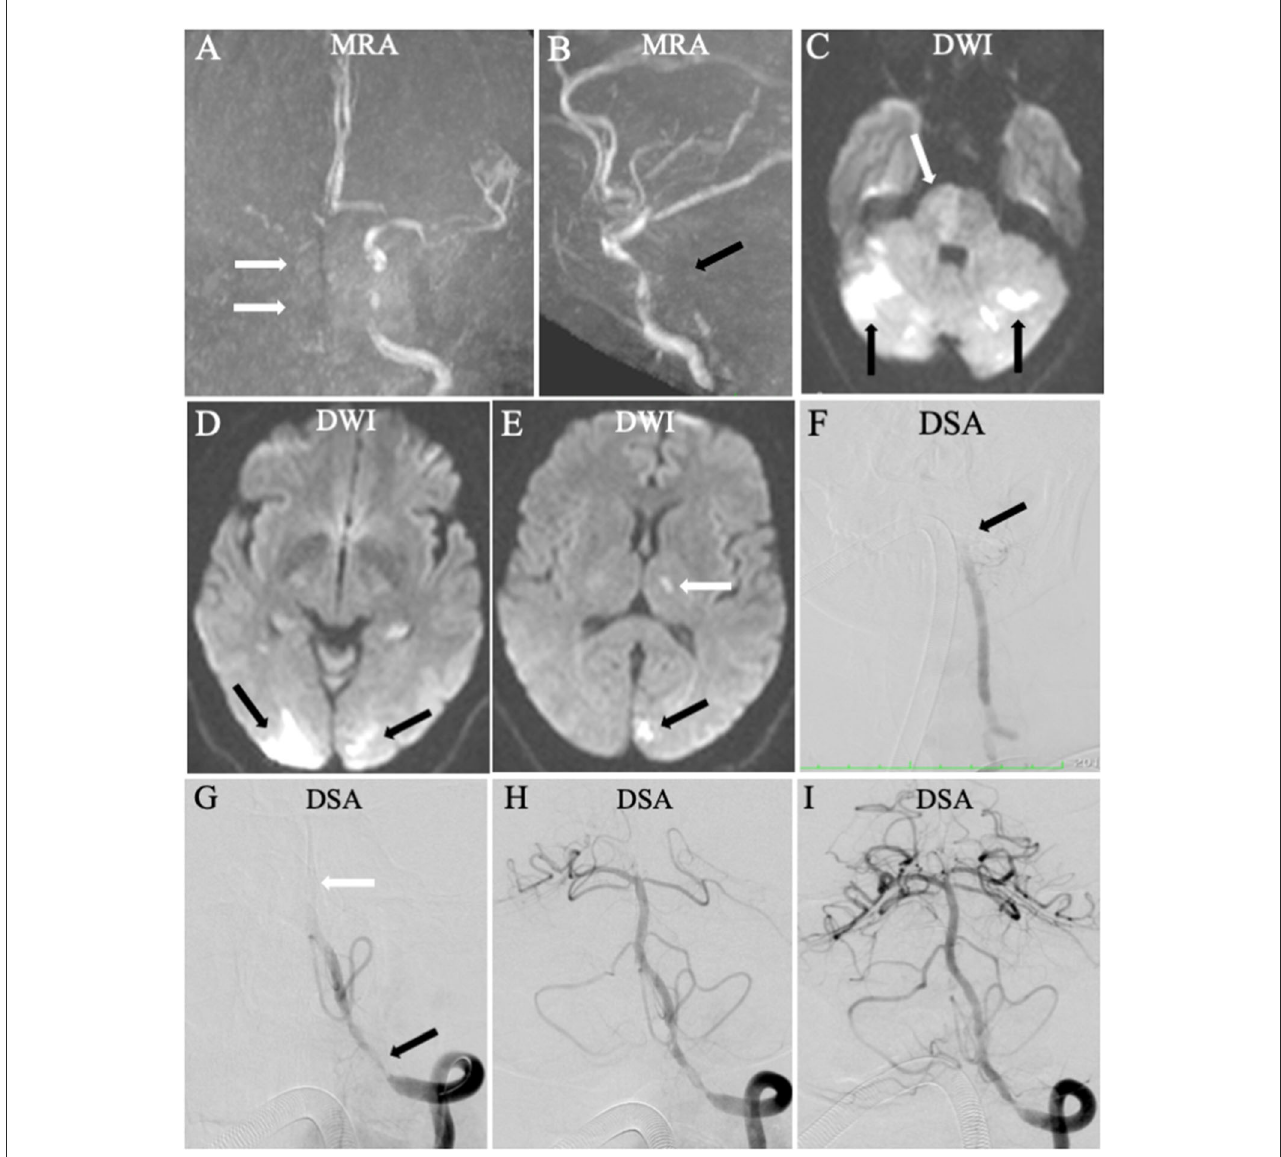
FIGURE1 Endovascular treatment (EVT) for a patient with higher National Institutes of Health Stroke Scale (NIHSS) score: 20 and lower Acute Stroke Prognosis Early Computed Tomography Score (ASPECTS). Magnetic resonance angiography displayed the right internal carotid artery occlusion [ (A) , arrow] and the vertebrobasilar artery occlusion [ (B) , black arrow]. Diffusion-weighted imaging showed multiple acute ischemic stroke in posterior circulation involving the right pons [ (C) , white arrow], bilateral cerebellum [ (C) , black arrow], bilateral occipital lobe [ (D) , black arrow], and left ganglion [ (E) , white arrow]. The Acute Stroke Prognosis Early Computed Tomography Score (ASPECTS) and pons–midbrain index were 3 and 2, respectively. Based on the findings of DWI and MRA, the left vertebral and basilar artery was diagnosed as the “criminal” artery. Digital subtraction angiography (DSA) confirmed the artery